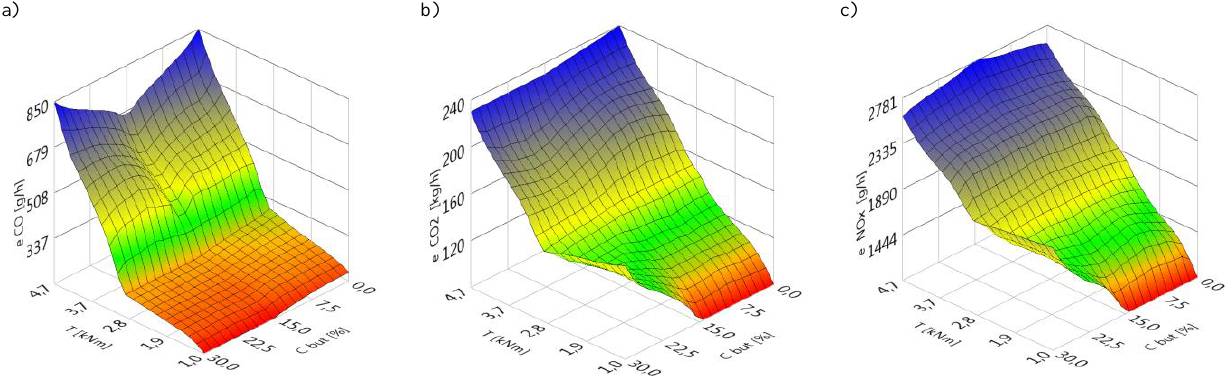
Fig. 8. The surface of emission intensity: a) carbon monoxide, b) carbon dioxide, c) nitrogen oxides at rotation speed n = 675 rpm